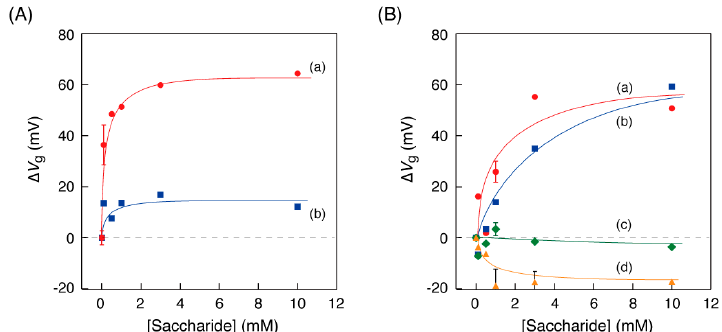
Figure 5 Shifts of the gate voltage ( ∆ V g at I DS = 10 − 11 A) in case of (A) the GOx-PB electrode, depending on the concentration of (a: circle) glucose and (b: square) 1,5-AG and in case of (B) the POx-PB electrode, depending on the concentration of (a: circle) glucose, (b: square) 1,5-AG, (c: diamond) mannose and (d: triangle) galactose in 1×PBS at 25 °C. The error bars indicate the standard deviation of three or four measurements.